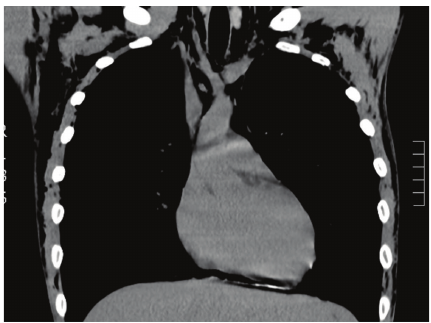
Figure 2: Coronal CT image showing pneumomediastinum and subcutaneous